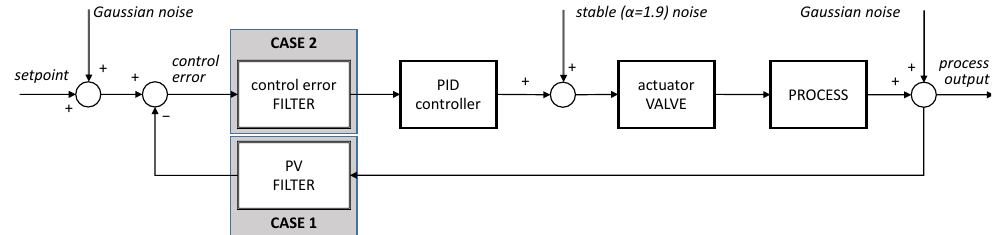
Figure 2. Simulation environment for noise filter analysis. The actuator device, the valve in the considered case, is separately isolated.